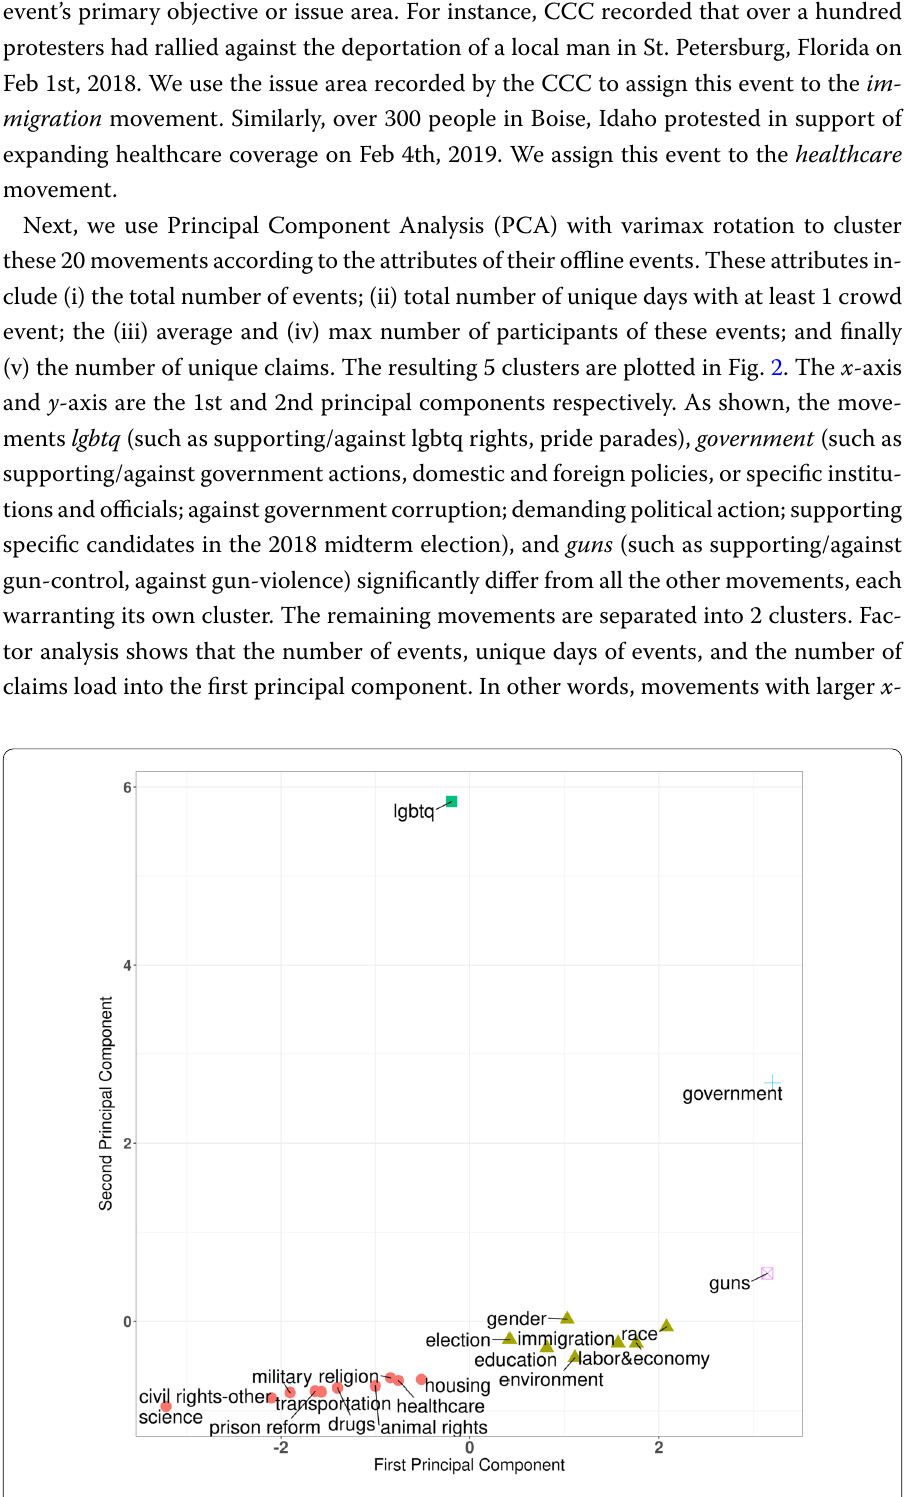
Figure 2 Movements Clustered Using Their Offline